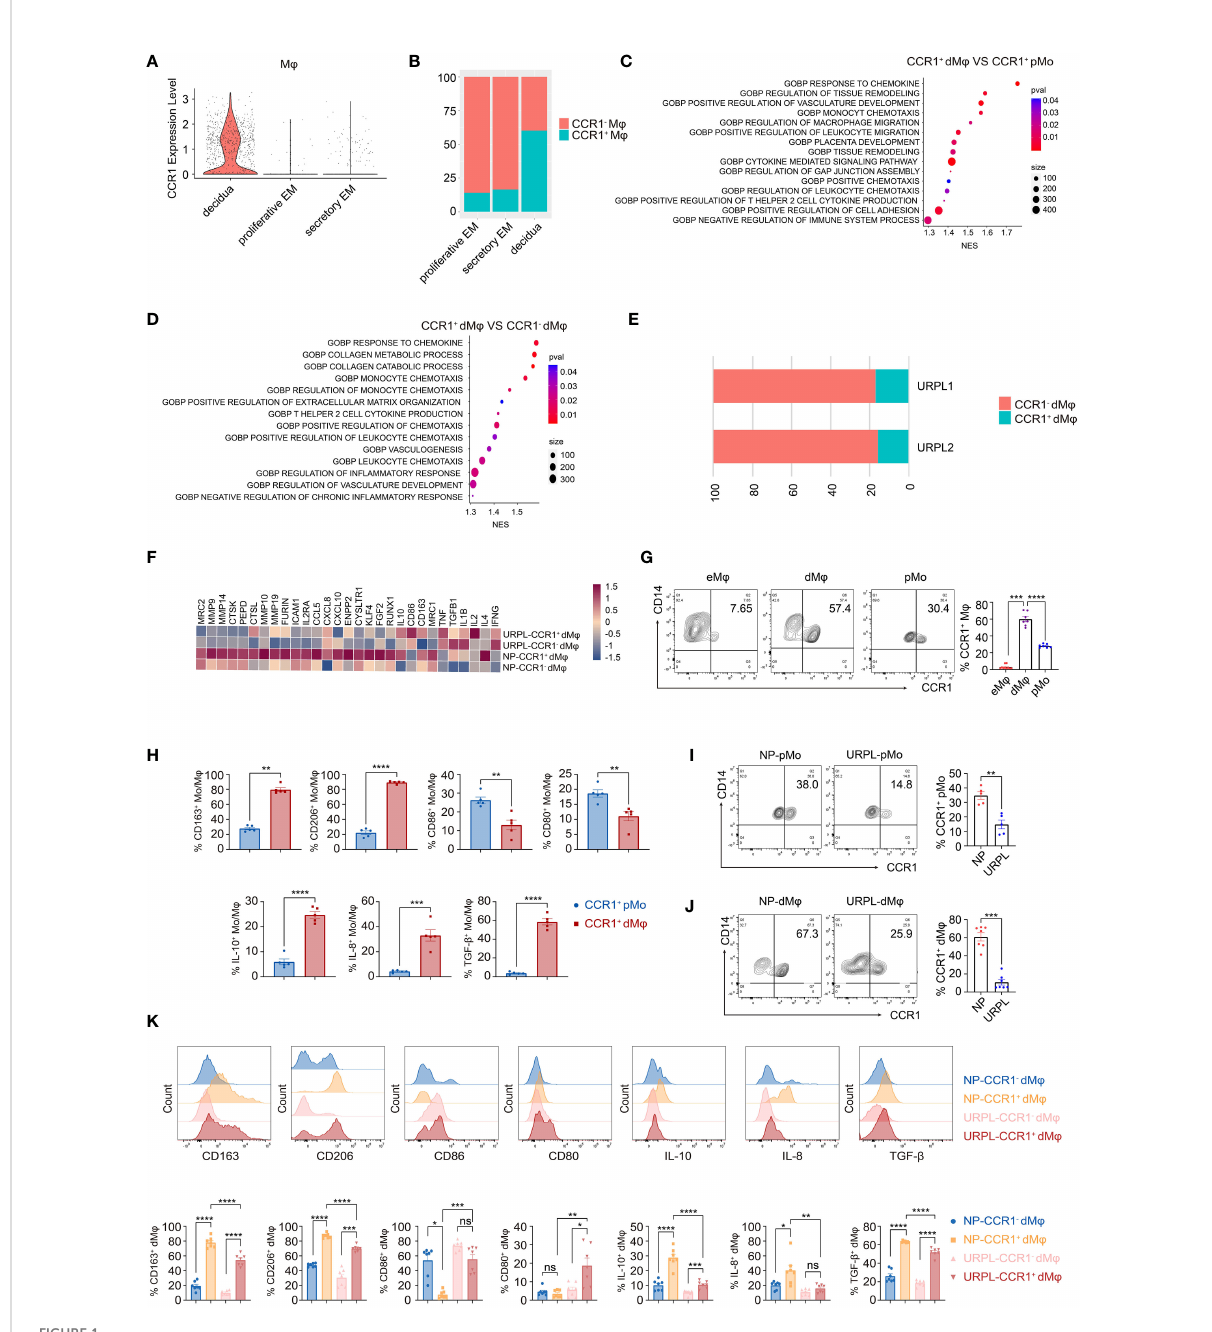
FIGURE 1 CCR1 + dM j possess a distinct phenotype in URPL patients. (A) The violin plot representing CCR1 expression of macrophages in the endometrium and decidua. (B) Histogram indicating the proportion of CCR1 - and CCR1 + macrophages in the endometrium and decidua. (C, D) Gene Ontology (GO) analysis was conducted to identify speci fi c pathways between CCR1 + peripheral monocytes (pMo) and decidual macrophages (dM j ) (C) and between CCR1 - and CCR1 + dM j (D) . (E) Histogram illustrating the percentage of CCR1 - and CCR1 + dM j in patients with unexplained recurrent pregnancy loss (URPL). (F) Heatmap depicting the expression of selected genes in CCR1 - and CCR1 + dM j from normal pregnancies (NPs) and URPL. (G) Representative plots and quanti fi cation of CCR1 + eM j (n=10), dM j (n=7), and pMo (n=7). (H) FCM of the expression of indicated membrane molecules and cytokines in CCR1 + pMo and CCR1 + dM j . 5 samples from two independent experiments. (I, J) Representative plots and quanti fi cation of CCR1 + pMo (n=5; 5) (I) and CCR1 + dM j (n=7; 7) (J) between NPs and URPL. (K) Quanti fi cation of membrane molecules and intracellular cytokines of CCR1 - and CCR1 + dM j from women with NPs (n=5) and URPL (n=5). Data are presented as mean ± SEM. ns, not signi fi cant; *p < 0.05, **p < 0.01, ***p < 0.001, ****p <